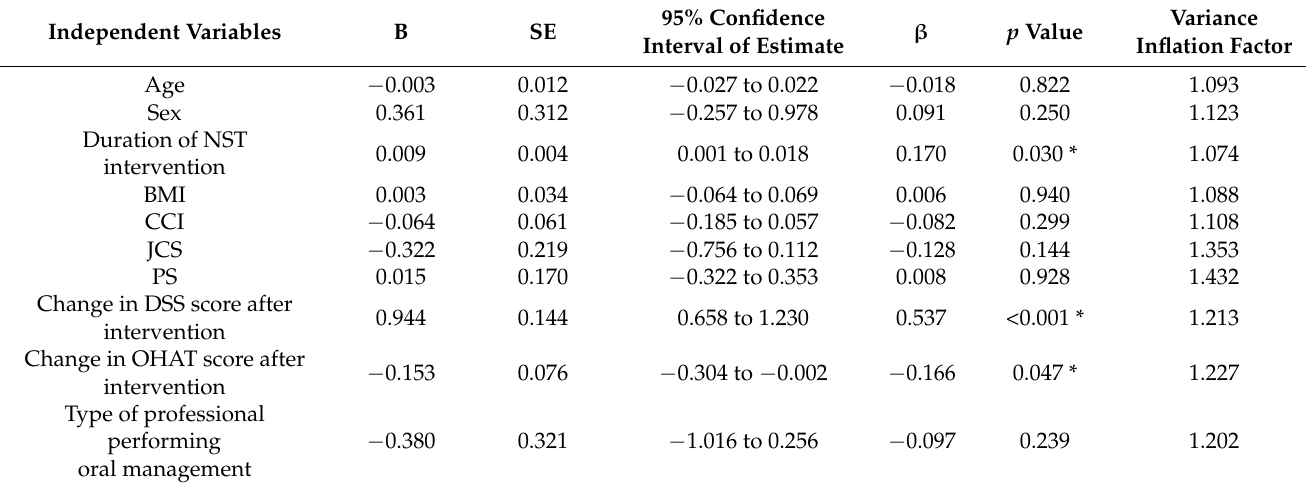
Table 3. Factors affecting changes in FOIS scores after the NST intervention including multidisci- plinary oral health